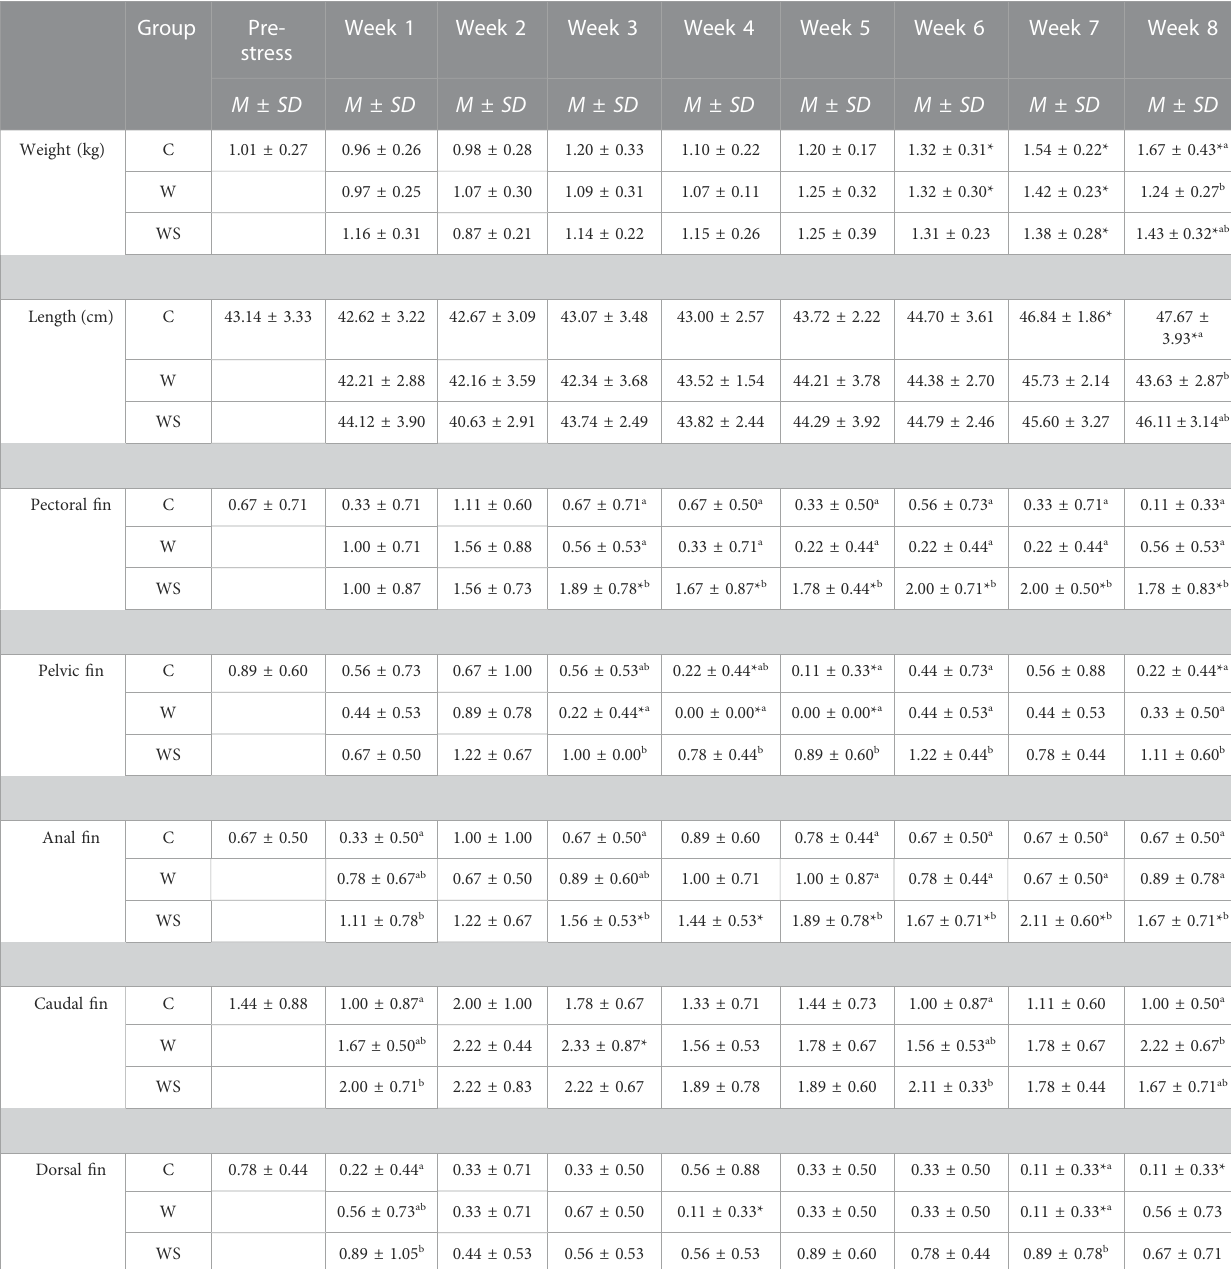
TABLE3Mean±SD(n=9)ofweight(kg),length(cm),pectoral, pelvic,anal,caudal,anddorsal fi ns(scored 0 – 3)incontrol(C),wound(W),andwound+stress (WS) during an 8-week experimental timespan (tertiary stress responses).